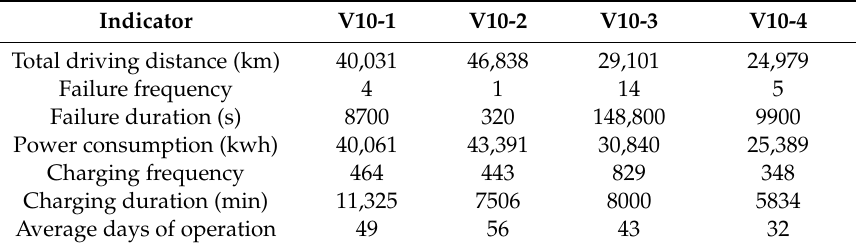
Table 7. Indicator Data Collected for Group